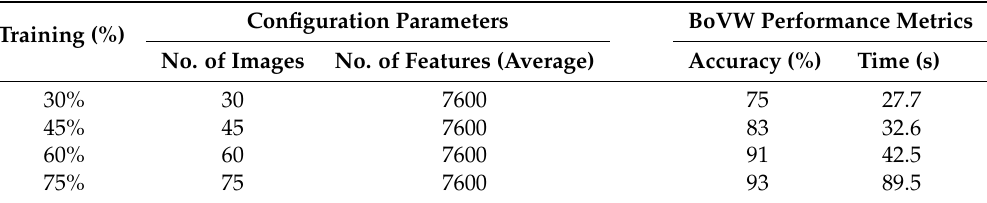
Table 1. Performance of BoVW using SURF as the image feature detector and descriptor. The table represents the number of images used in the training process, while the rest of the database is used for the evaluation purpose. The processing time is measured in seconds.